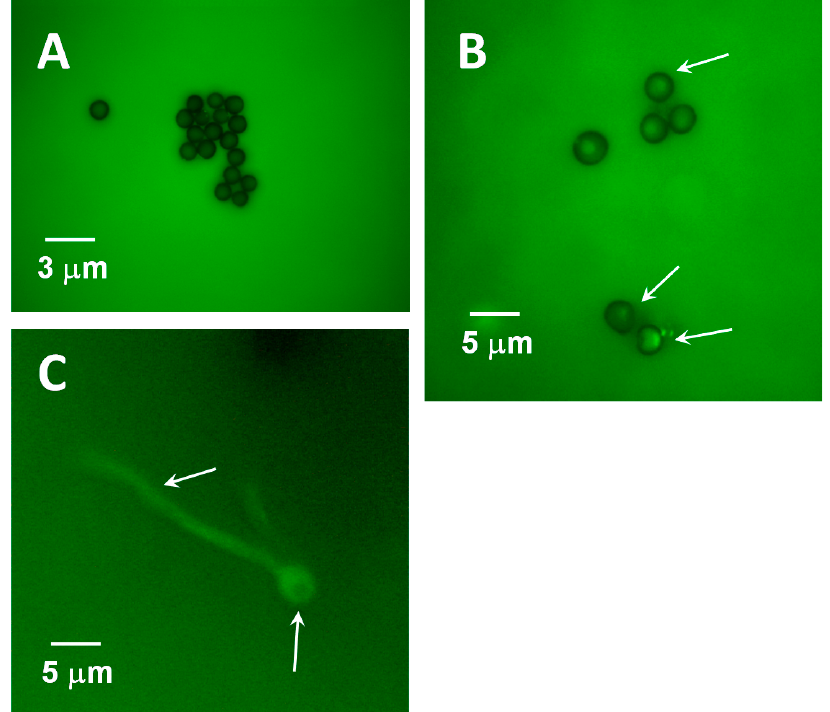
Figure 5. Polarization of the F-actin microfibrils and appearance of capping after the incubation of teliospores with fluorescein isothiocyanate (FITC)-phalloidin. ( A ) Resting cells in which capping did not appear. ( B ) Initiation of capping (arrows) after a few hours of rehydration. ( C ) A germinated spore, with the hypha emerging from the teliospore through the germinative pore, as signalized by the capping. The dark zone opposite to this germination point can be observed (arrow). The cytoplasm polarization marked by the formation of F-actin microfibrils is pre- vented by the use of several inhibitors, such as phalloidin, an actin cytoskeleton stabilizer that prevents the depolymerization of F-actin [59], latrunculin A, which is a chemical agent that keeps actin depolymerized [54], or blebbistatin, which is a myosin II con- tractility inhibitor [60]. In addition, several glycoproteins produced by the host plant, particularly that which exhibits arginase activity, can inhibit actin capping and, therefore, prevent teliospore